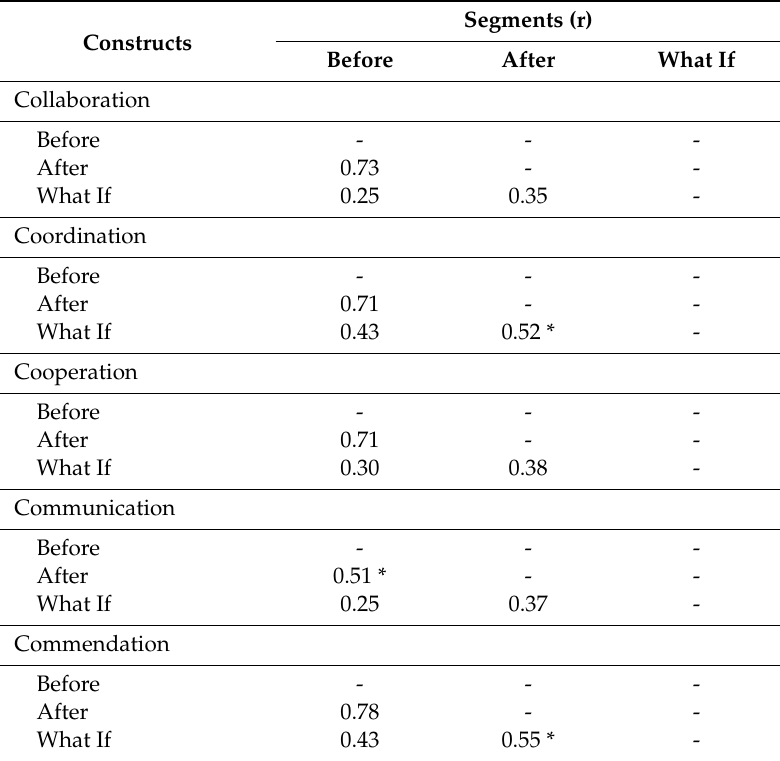
Table 6. Relation matrix of IPL constructs to